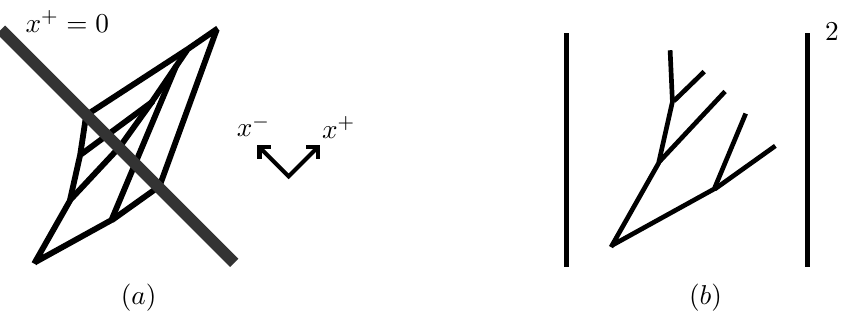
Figure 3 . (a) Scattering in the Regge limit. The thin shock is the Lorentz-contracted target. (b) Branching of soft gluons. To connect the pictures one ‘folds’ along the target and sends it to in(cid:12)nity. motivation for de(cid:12)ning eq. (1.2). (Mathematically similar considerations were used in refs. [24, 25] to exploit the conformal symmetry of the BFKL equation.) Note that in the Regge context there is a natural symmetry between the projectile and target impact